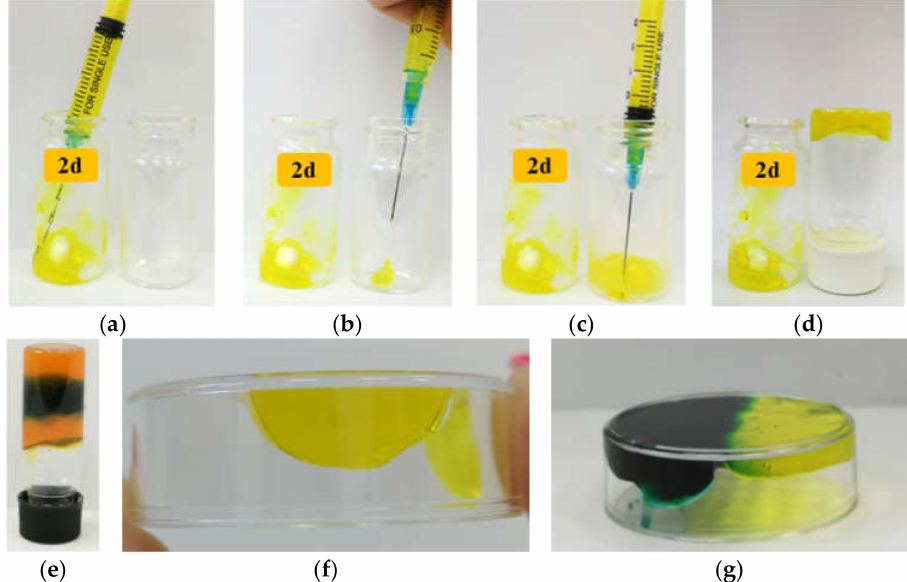
Figure 5. Images revealing the ability of the hydrogels to self-heal and to be injected ( a – d , f) represent pristine hydrogels injected through a needle, and ( e ) and ( g ) represent hydrogels stained with methylene blue and injected next to pristine hydrogel) (exemplified on the hydrogel 2d ).